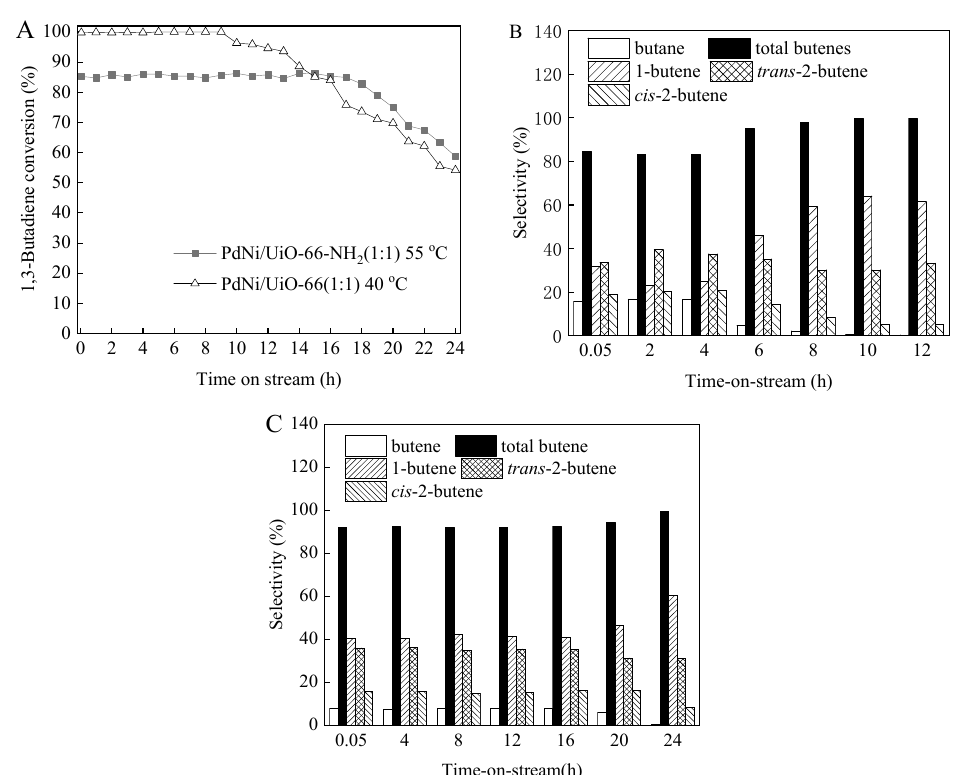
Figure 7. Evolution of the BD conversion and product selectivity with time-on-stream for PdNi/UiO- 66 (1:1) and PdNi/UiO-66-NH 2 (1:1) at 40 °C and 55 °C, respectively: ( A ) BD conversion; ( B ) Product selectivity for PdNi/UiO-66 (1:1); ( C ) Product selectivity for PdNi/UiO-66-NH 2 (1:1) (reaction conditions: 5 mg of catalyst, 6.5 mL/min of H 2 flow rate, 20 mL/min of 1.0 vol.%BD/N 2 flow rate).